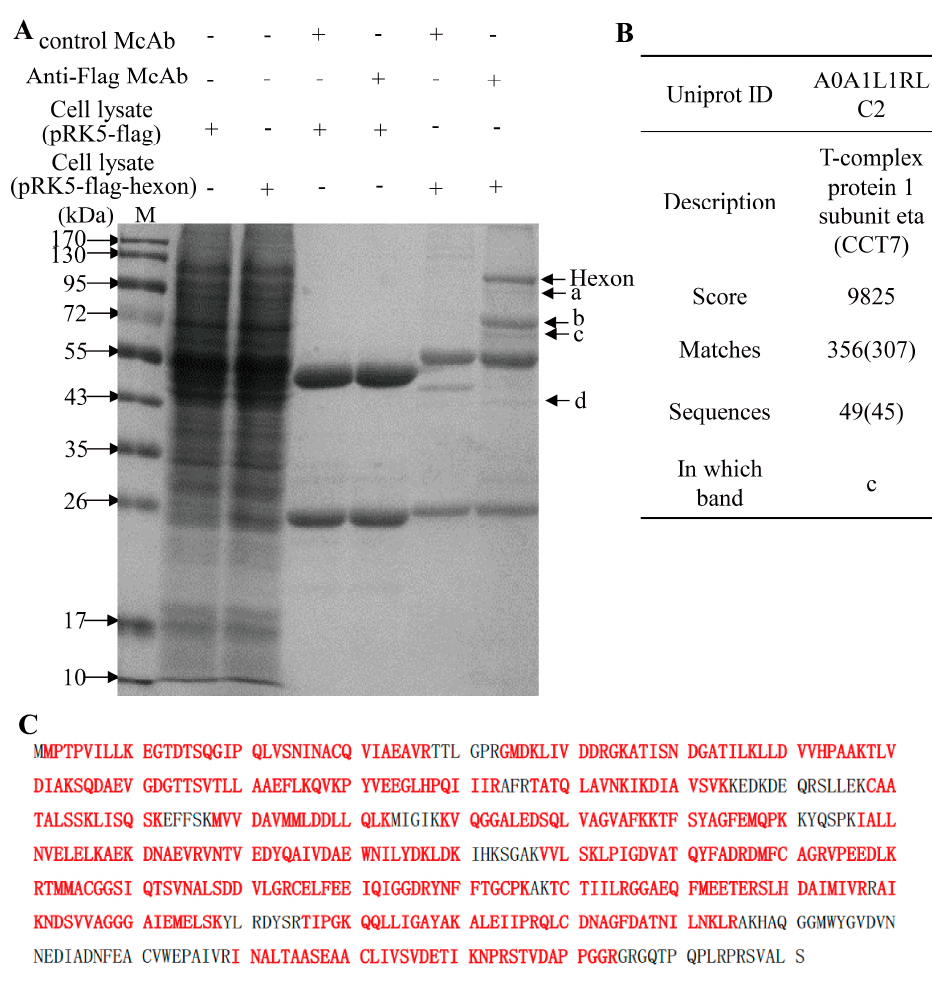
Figure 2. Screening for hexon-interacting proteins in LMH cells. ( A – C ) LMH cells transfected with pRK5-flag-hexon or pRK5-flag and subjected to a pull-down assay ( A ). The arrow-pointed protein bands in ( A ) were further analyzed by liquid chromatography-mass spectrograph (LC-MS), and the cellular protein CCT7 was identified from the arrow-pointed protein band c ( B ). The alignment of the chicken CCT7 sequences (UniProtKB: A0A1L1RLC2) with its matched peptides is shown in bold red as identified by LC-MS (C).